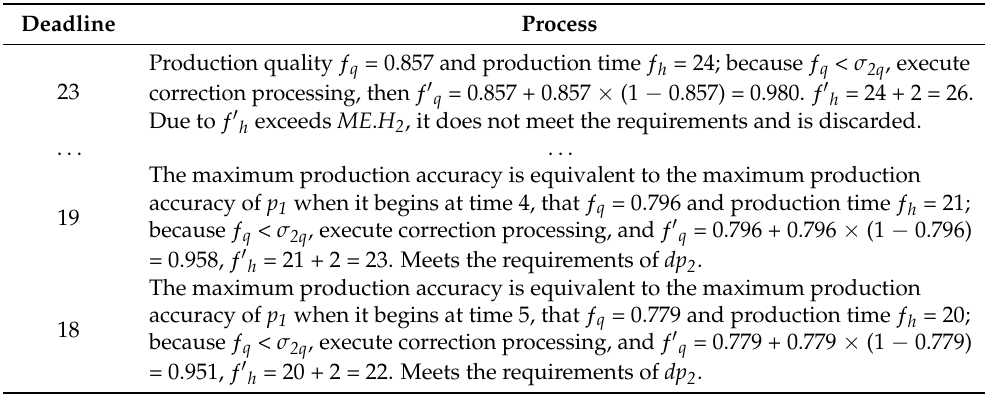
Table 4. Scheduling process and results of p (cid:48) [6–9] under different deadlines. Deadline